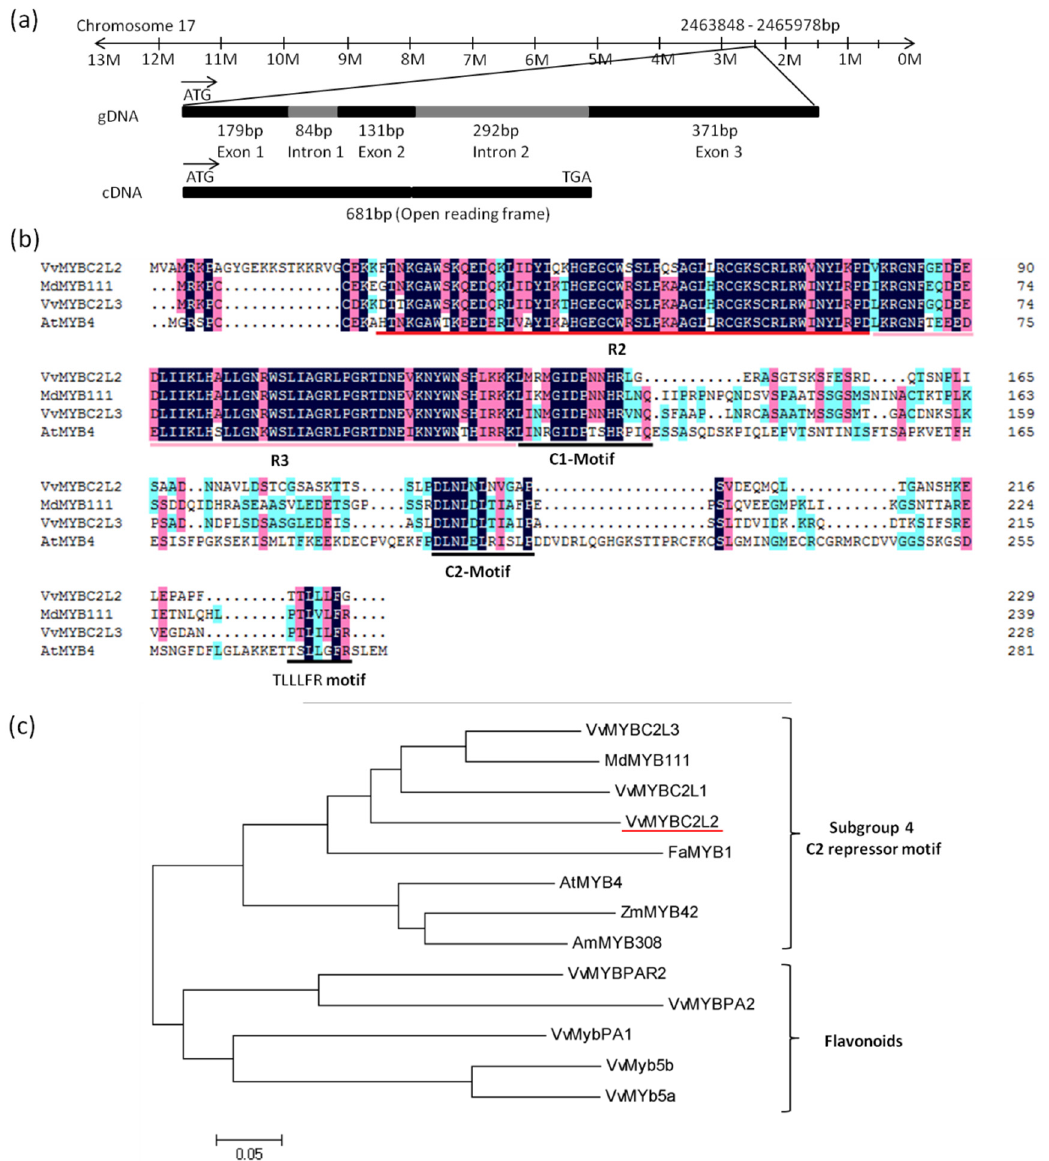
Figure 1. Features of the predicted VvMYBC2L2 protein. ( a ) The genomic sequence of VvMYBC2L2 . The 1057 bp gDNA of VvMYBC2L2 contains three exons and two introns. ( b ), Alignment of the deduced amino acid sequence of VvMYBC2L2 with other repressor R2R3-MYB proteins. R2 and R3 are the two repeats of the MYB DNA-binding domain. C1 motif, C2 motif and TLLLFR motif are also boxed at the C-terminus position. ( c ) Phylogenetic analysis of R2R3-MYB transcription factors. The phylogenetic tree was generated using the neighbor-joining method by the MEGA 5.0